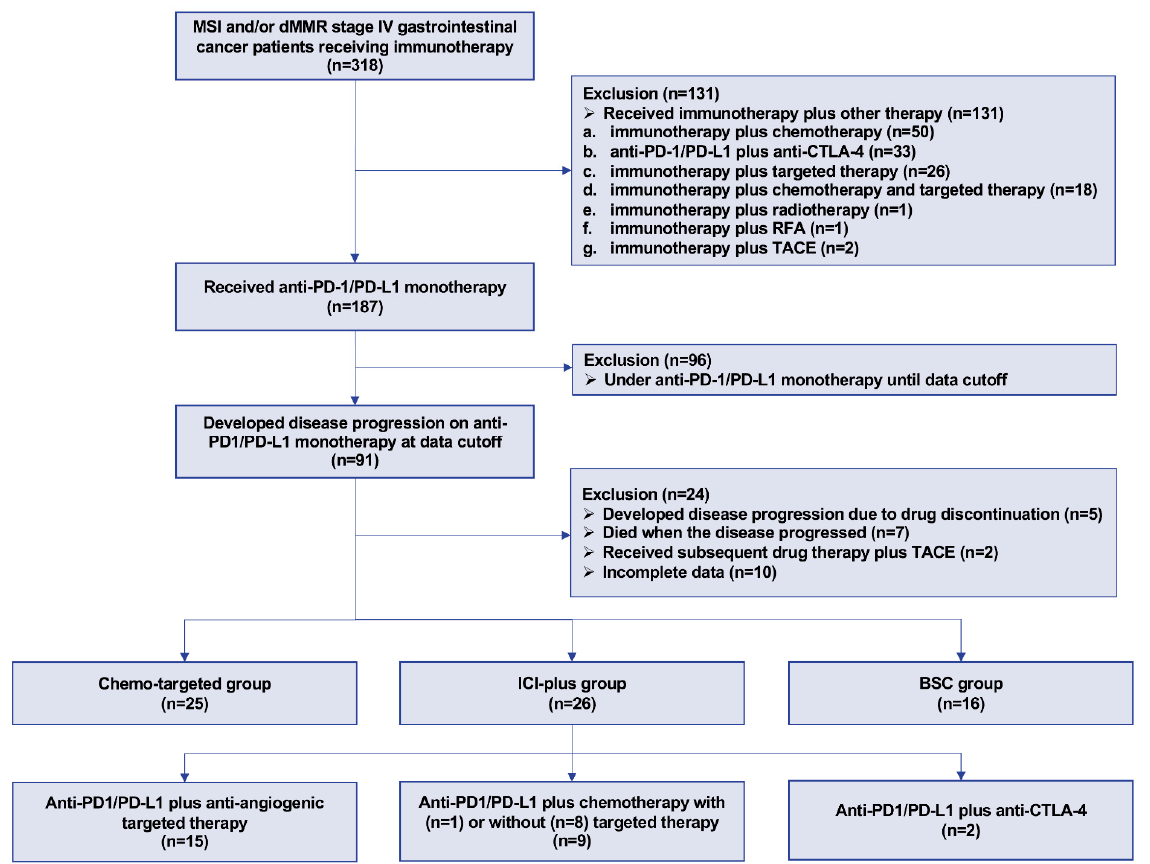
Figure 1. Flow chart of patient selection. Abbreviations: ICI-plus: anti-PD1/PD-L1 plus other therapy; chemo-targeted: chemotherapy with or without targeted therapy; BSC: best supportive care; CTLA-4 = cytotoxic T lymphocyte-associated antigen-4; dMMR = mismatch repair-deficient; MSI = microsatellite instability; PD1 = programmed death 1; PD-L1 = programmed death ligand-1; RFA = radiofrequency ablation; TACE = transcatheter arterial chemoembolization.